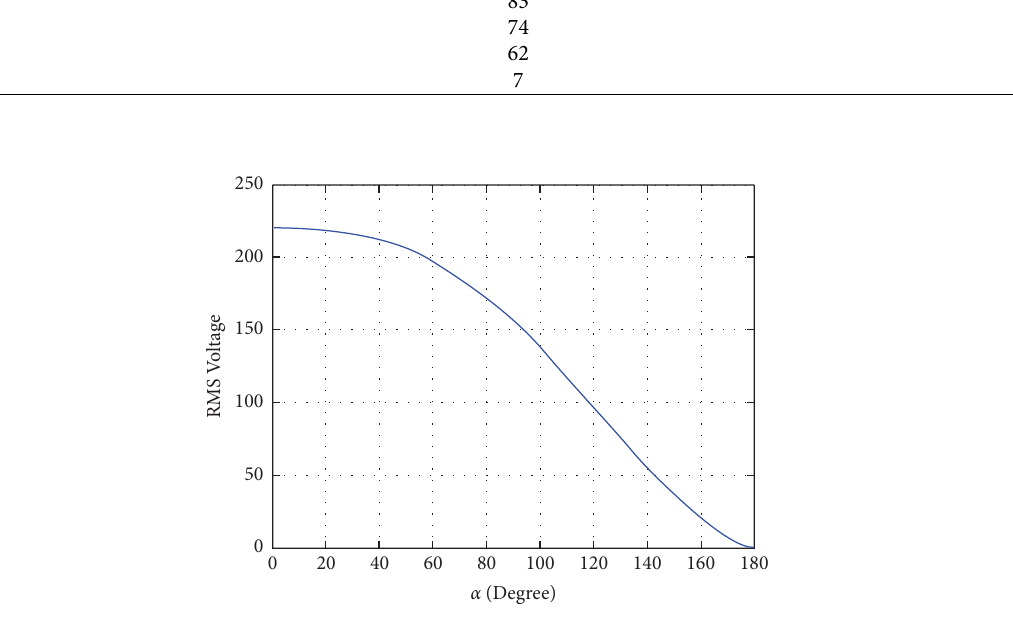
w.r.t fring angle. rms